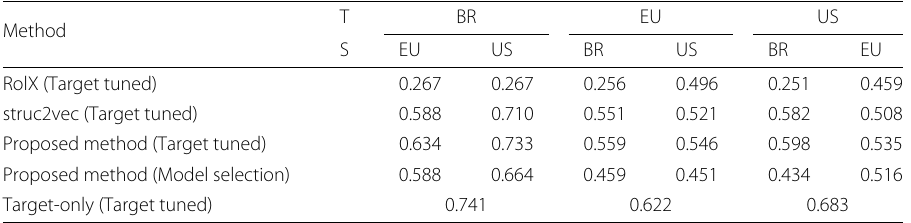
Table 5 Results of air-traffic